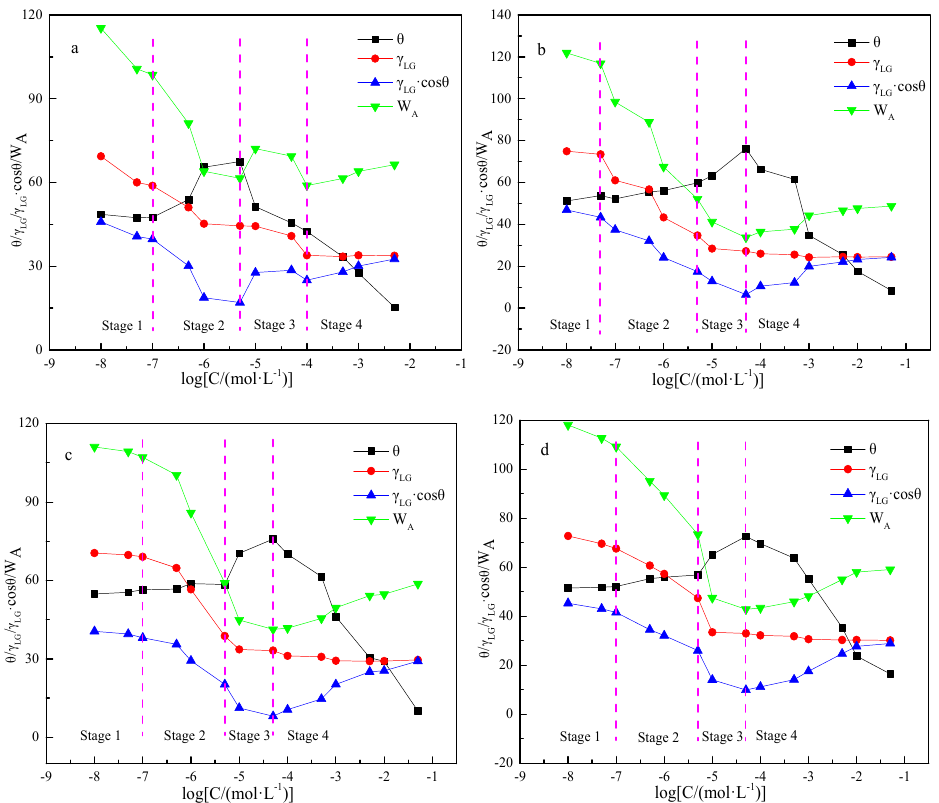
Figure 9. Adhesional data as a function of log C of fatty acid solutions ( a : SA; b : OA; c : LA; d : ALA).